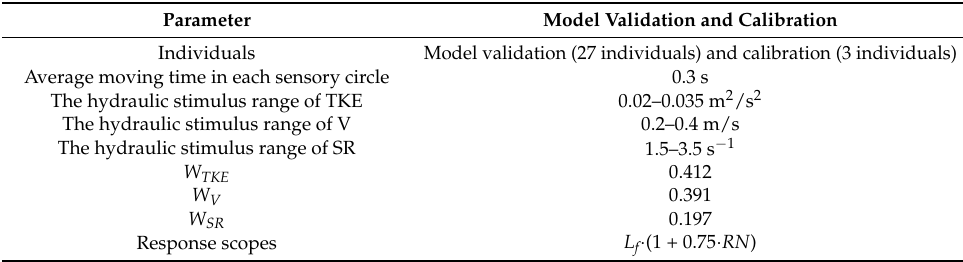
Table 2. The model